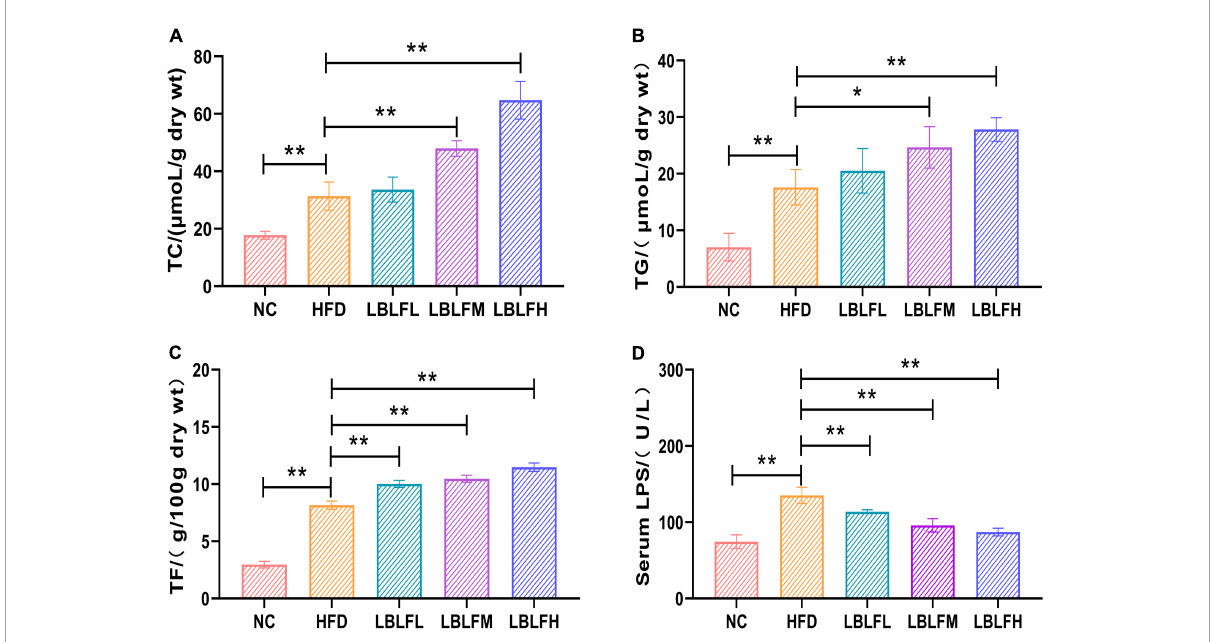
FIGURE3 Effects of LBLF supplement on fecal lipids content and serum LPS (lipase) activity in obese mice. (A) Mean content of TC (total cholesterol); (B) mean content of TG (total triglyceride); (C) mean content of TF (total fat); (D) mean activity of serum LPS (lipase). (* p < 0.05) and (** p < 0.01) vs. HFD